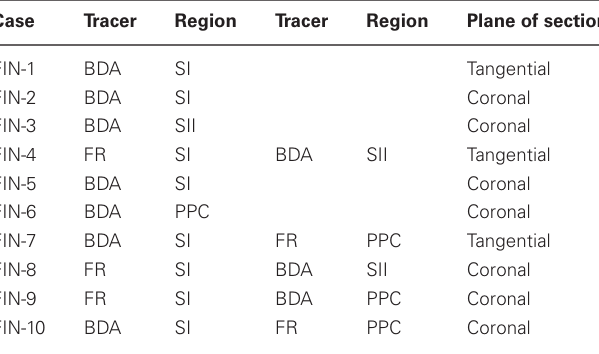
Table 1 | Summary of tracer injections.